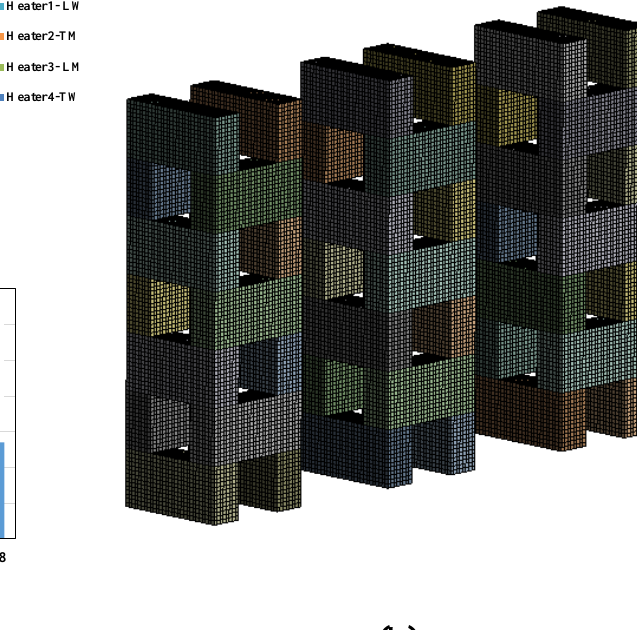
Table 2. The inlet mass flow rate in the present four settings (kg/s).